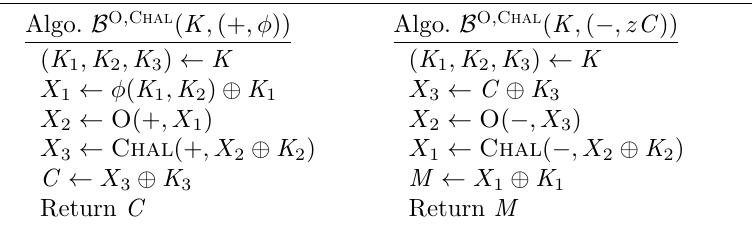
Figure 11: Algorithm B used in the KDM analysis of two-round EM with a single